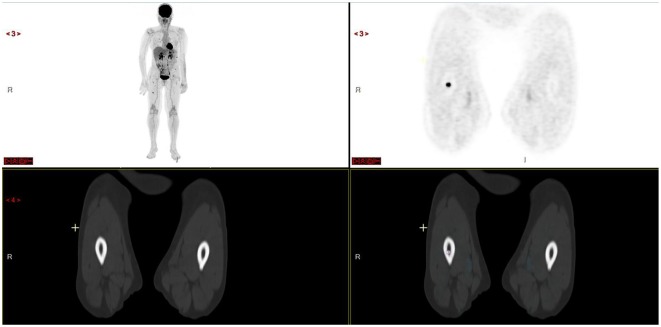
Patient with more than 10 focal lesions of the axial and appendicular skeleton. Note absence of osteolysis on opposite CT scan of right femur focal lesion.